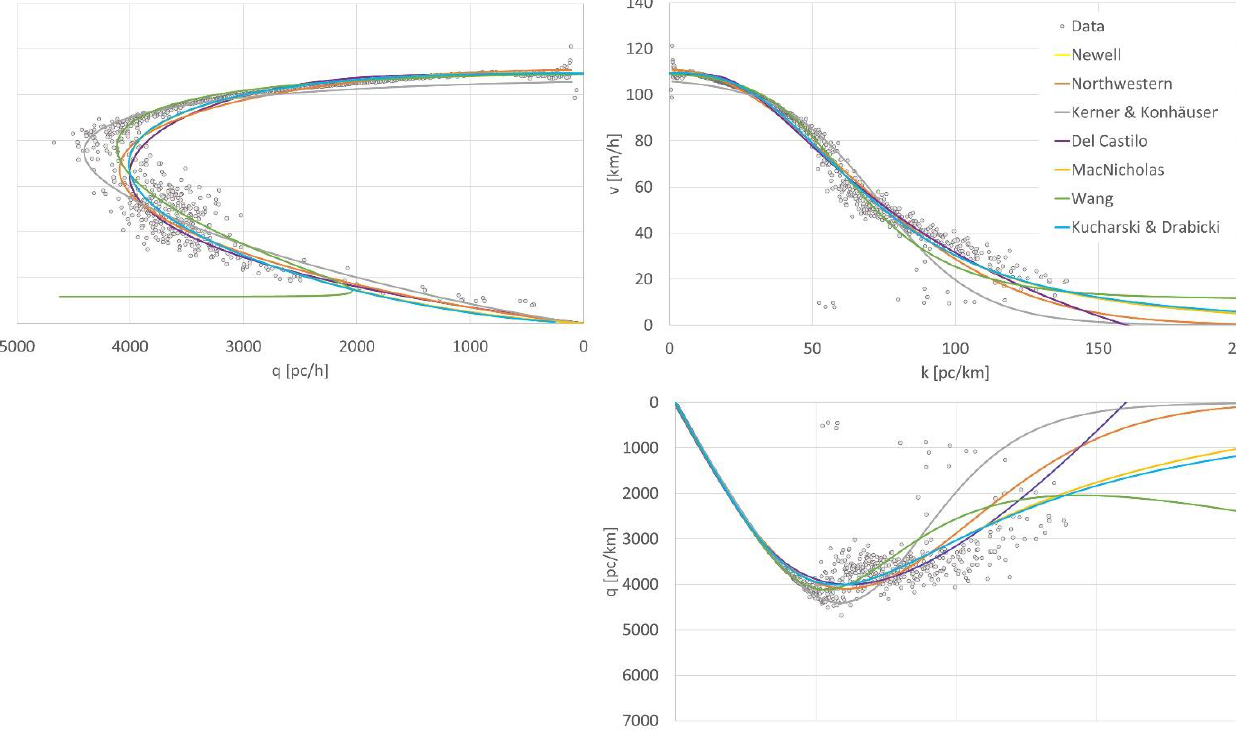
Figure 7. Fundamental diagram represented by single-regime models — group 2.